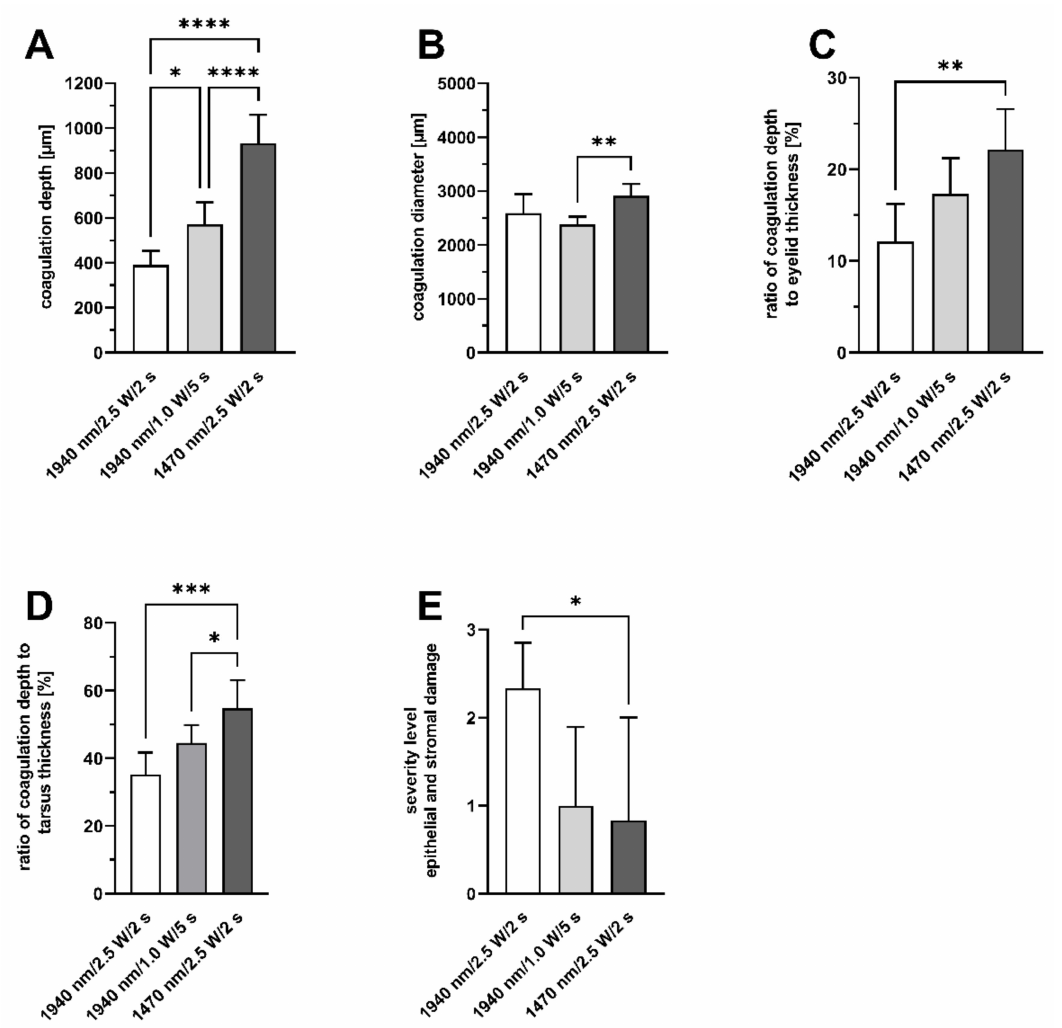
Figure 3. Histological results of laser coagulations of porcine eyelids in a histological cross section. ( A ): Depth of coagulation. ( B ): Diameter of coagulation (measured at the epithelium). ( C ): Percentage of coagulation depth to lid thickness. ( D ): Percentage of coagulation depth to tarsus thickness. ( E ): Severity of epithelial and stromal damage. * p < 0.04 ** p < 0.007 *** p < 0.002; **** p <